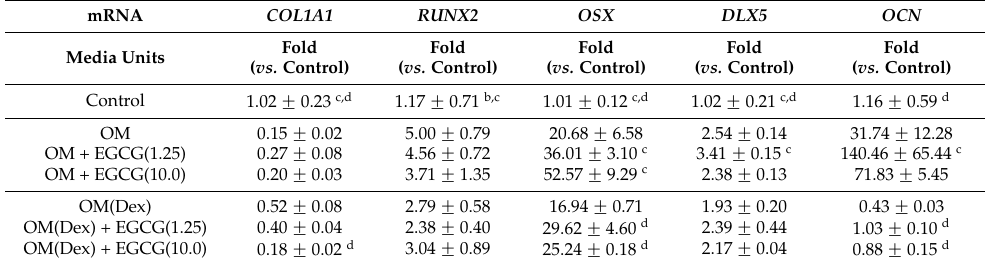
Table 3. mRNA expression levels of osteogenic markers in DFAT cells treated with media on day 6. mRNA COL1A1 RUNX2 OSX DLX5 OCN Fold Fold Fold Fold Fold Media Units ( vs. Control) ( vs. Control) ( vs. Control) ( vs. Control) ( vs. Control) Control